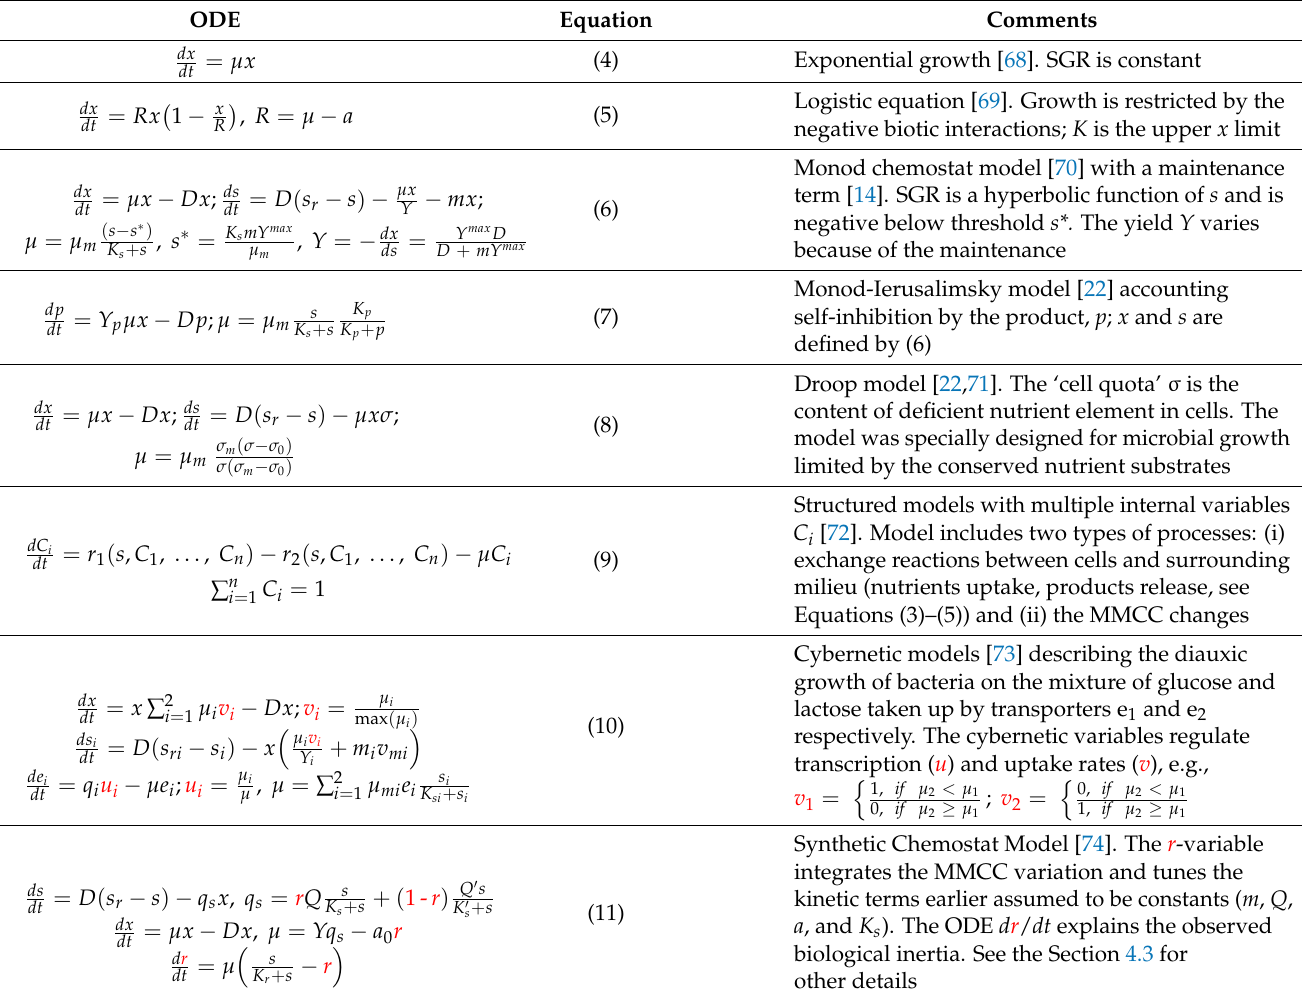
Table 1. Pre-genomic models of microbial growth